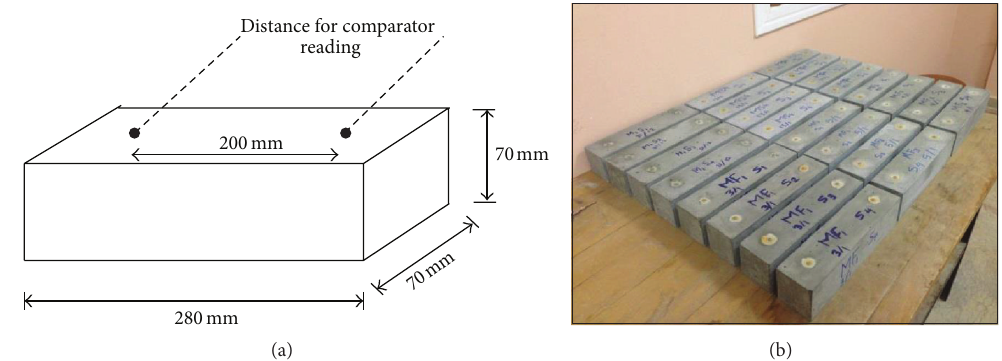
Figure 6: Free shrinkage test: (a) free shrinkage test setup and (b) test specimens.